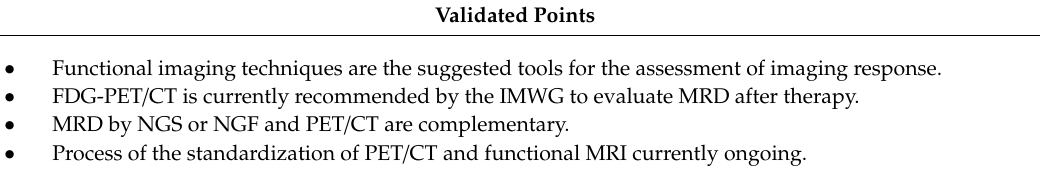
Table 3. Validated points and issues to be addressed by on-going trials for imaging-MRD evaluation. Validated